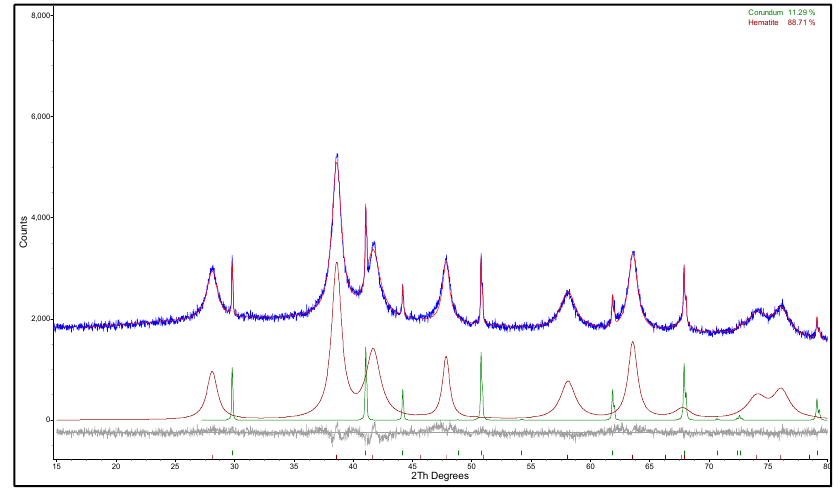
Figure A3. Calculated XRD patterns of hematite and jarosite formed in the experiments. Hematite was the dominant phase for initial ferric levels < 15 g / L Fe(III) while jarosite was favored at ferric concentrations > 15 g / L Fe(III). Actual collected patterns for these minerals are shown in Figures A4 and A5.